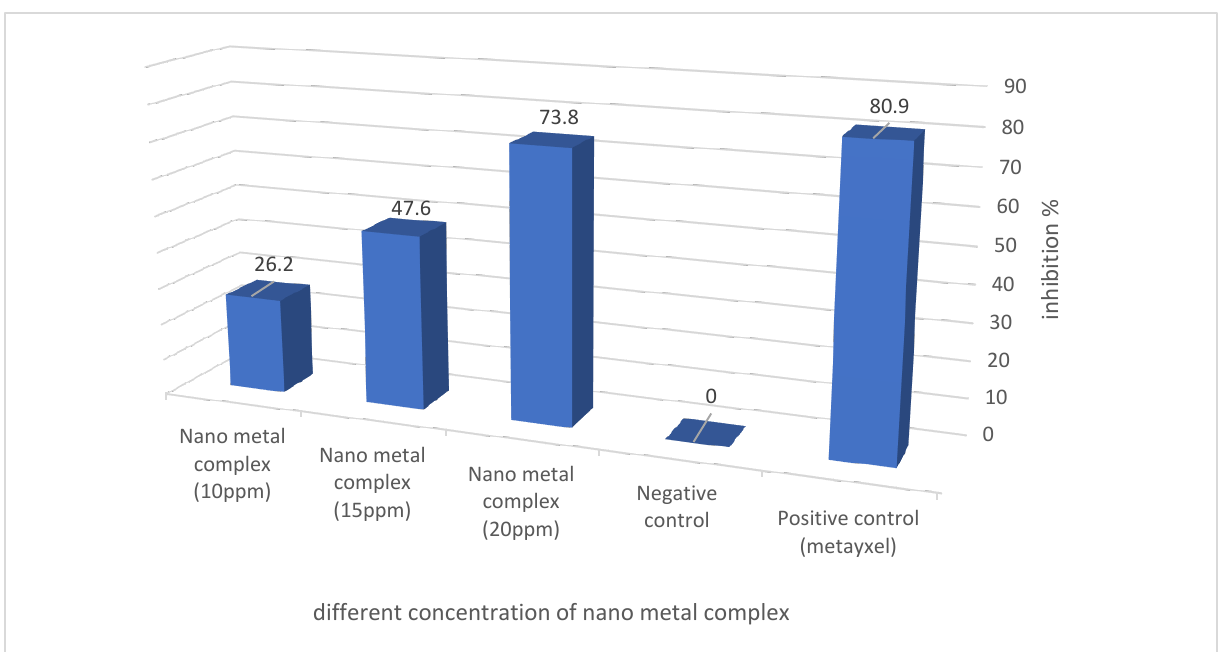
Figure 7. Inhibition % of P. aphanidermatum exposed to different concentration of nano-metal complex, on PDA at 26 °C for 6 days in the dark.